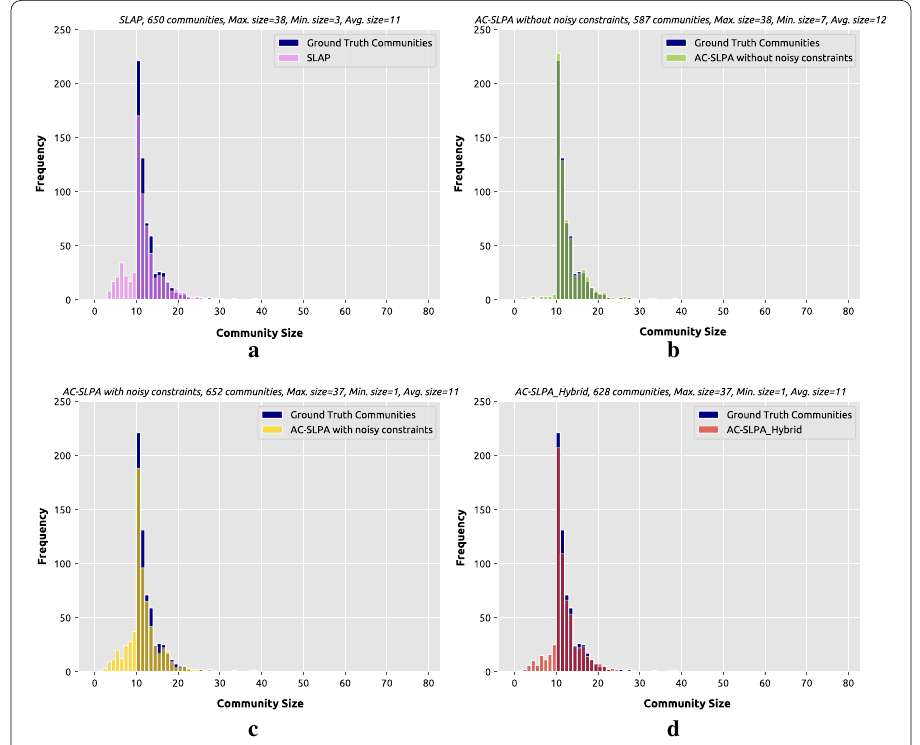
Fig. 15 Community size distribution for communities produced by SLPA, AC-SLPA with noisy pairwise constraints, and AC-SLPA with Hybrid cleaning on the DBLP network, compared to the ground truth community size